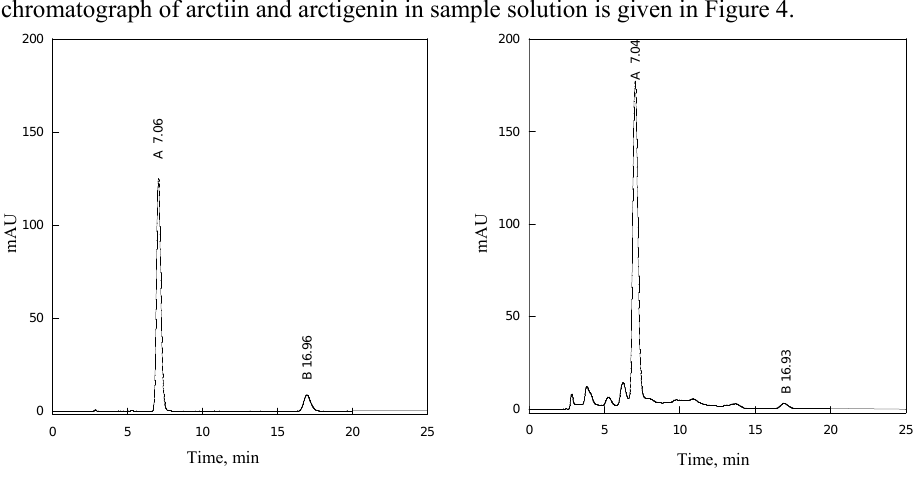
Figure 4. Arctium tomentosum Mill. sample solution (A: arctiin, B: